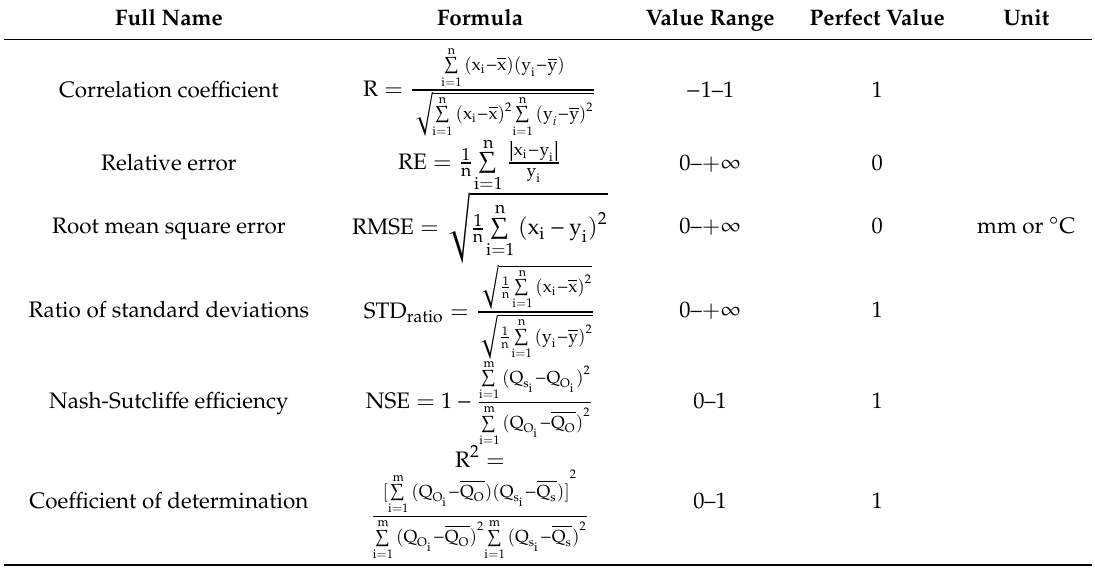
Table 3. Statistical indices for the evaluation of precipitation, temperature, and runo ff in this study.